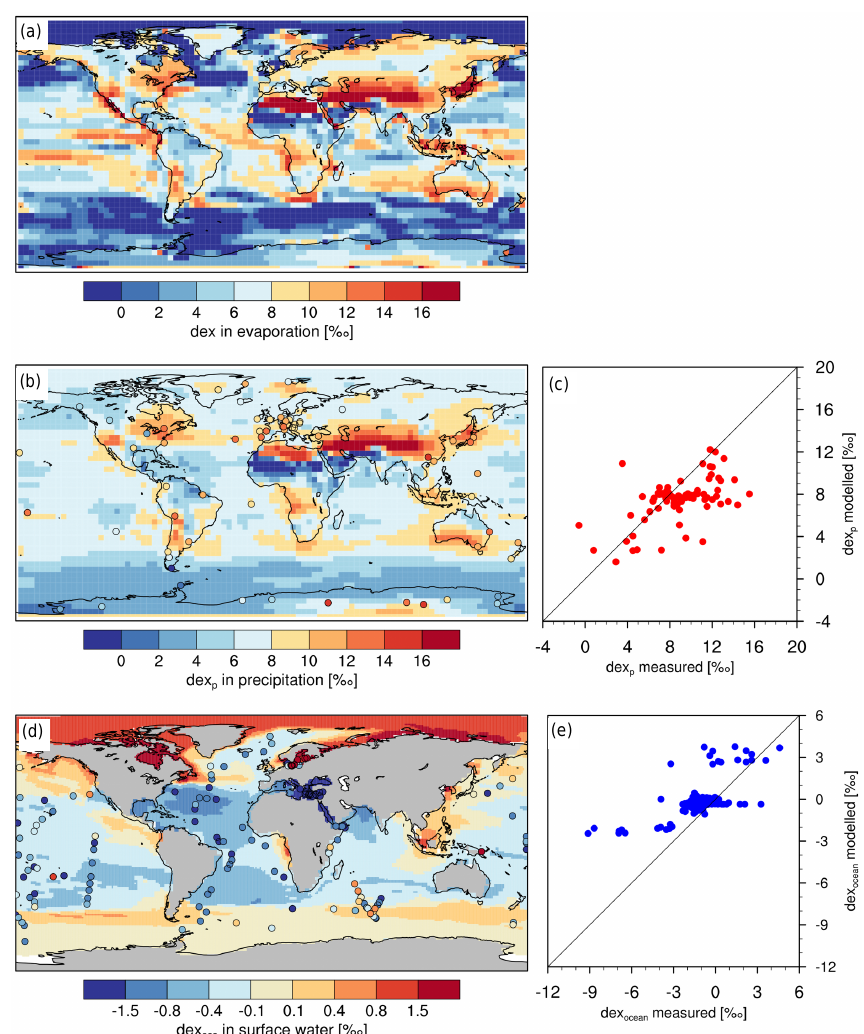
Figure 6. Global distribution of simulated and observed annual mean deuterium excess (dex) values in (a) evaporation, (b) precipitation, and (d) ocean surface waters. The background pattern shows the dex distribution as simulated by ECHAM5/MPI-OM. In panel (b) , data from 70 GNIP stations and 21 ice cores from Greenland and Antarctica are plotted as coloured symbols. In panel (d) , 153 data entries from the GISS database are plotted as coloured symbols. Comparison of observed present-day dex values in (c) precipitation (red symbols) and in (e) ocean surface waters (blue symbols) vs. the corresponding modelled dex values of the PI simulation. The black lines in panels (c) and (e) represent the 1:1 line indicating a perfect model